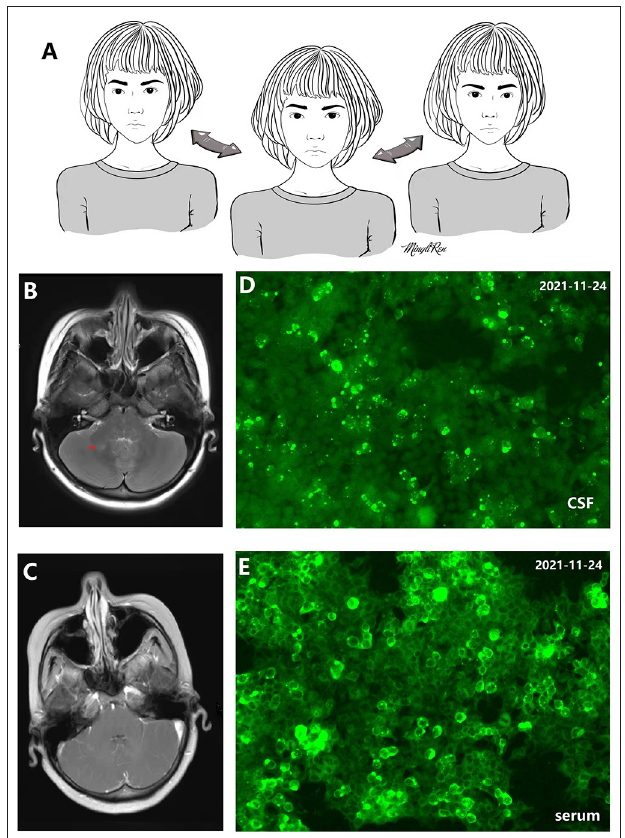
FIGURE 1 | (A) 2D picture associated with Supplementary Video 1 showing uncontrollable and quick head shaking. (B,C) Increased signal in the right cerebellar hemisphere without enhancement. (D) Antibody in cerebrospinal fluid (CSF) recognizes Homer-3 antigens in fifixed HEK293 cells. Anti-Homer-3 antibody titers in CSF: 1:3.2. (E) Antibody in serum recognizes Homer-3 antigens in fifixed HEK293 cells. Anti-Homer-3 antibody titers in serum: 1:100.